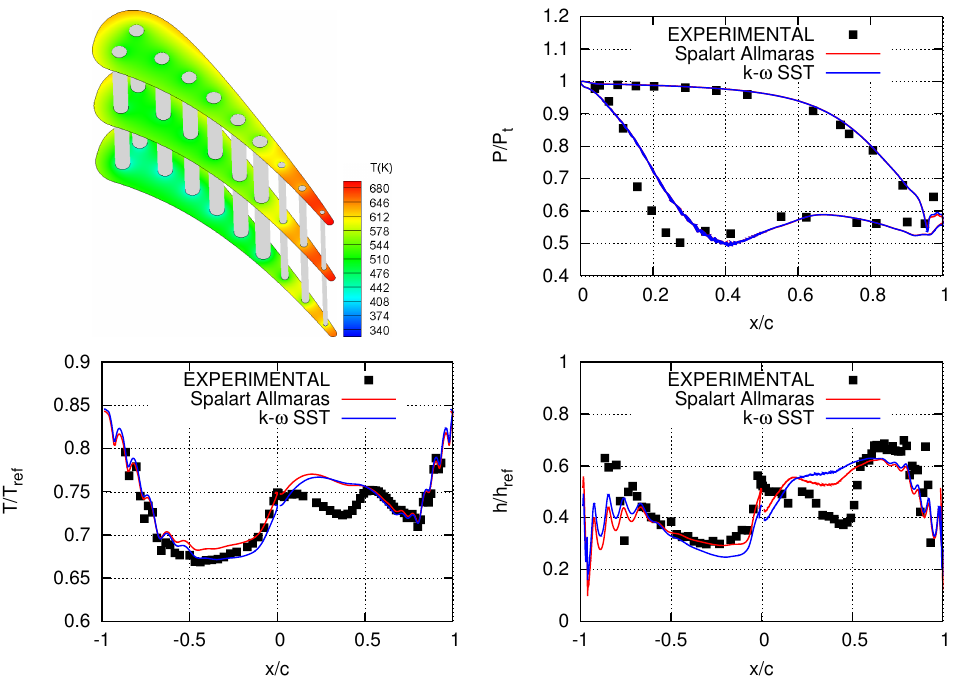
Figure 2. Computed T S fields ( top left ) at the solid blade’s hub, midspan, and shroud. Computed pressure ( top right ), temperature ( bottom left ), and heat transfer coefficient ( bottom right ) distri- butions across the blade midspan compared with measurements. Pressure is non-dimensionalized by the inlet total pressure of 243,700 Pa, temperature by 811K, and the heat transfer coefficient by 1135.6W/m 2